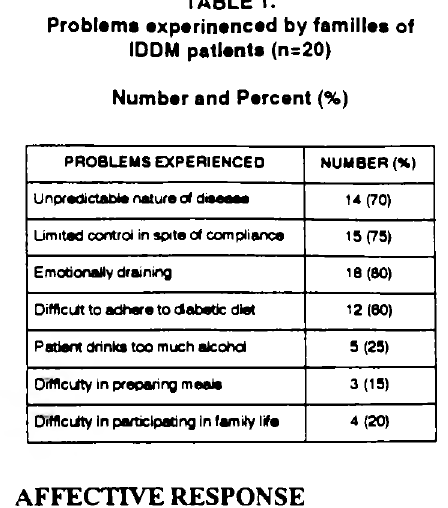
TABLE 1. Problem* *xp*rin*nc*d by famill** of IDDM patients